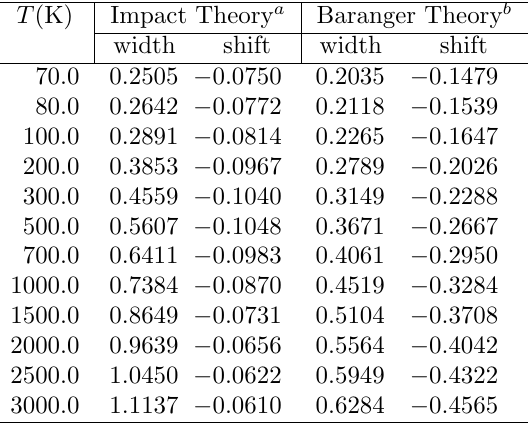
Table 8. Transition Na 3d 2 D{3p 2 P at 819.32 nm broadened by helium. Half half-widths w=N and shifts d=N (in units of 10 (cid:0) 21 MHz m 3 /atom = (2 (cid:25) ) (cid:0) 1 (cid:2) 10 (cid:0) 9 rad s (cid:0) 1 cm 3 /atom)